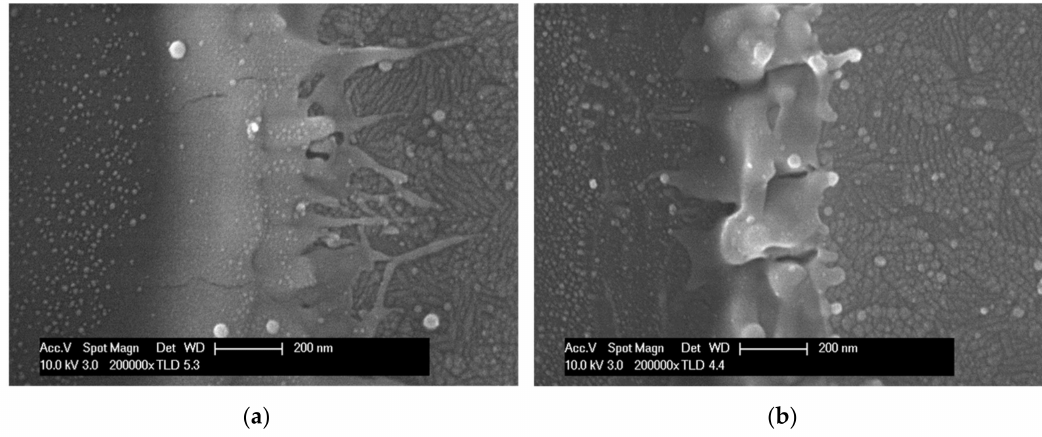
Figure 3. SEM images; Parts ( a ) and ( b ) are the 5 × enlarged versions of Figure 2b,d, respectively.